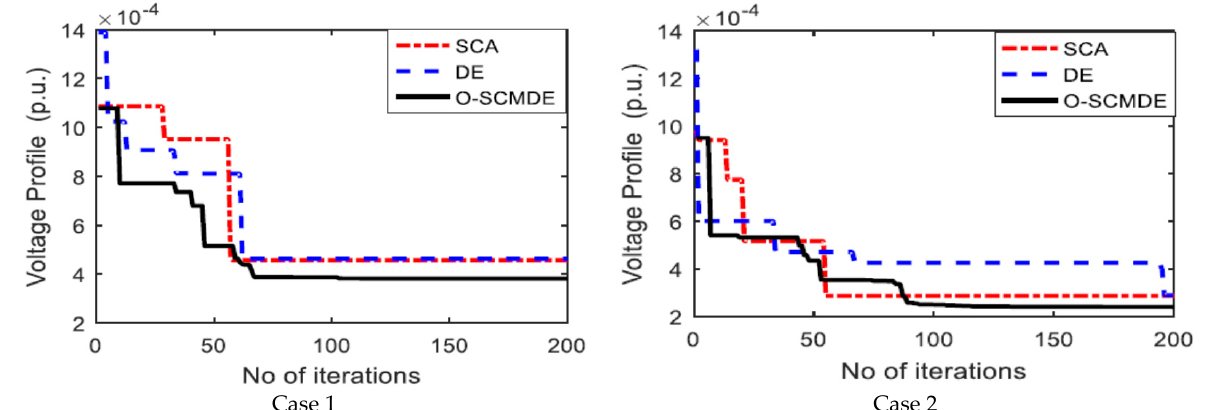
Figure 3. Comparison of the convergence characteristics of the SCA, DEA and O-SCMDEA for both cases of scenario II of the 33 bus system.